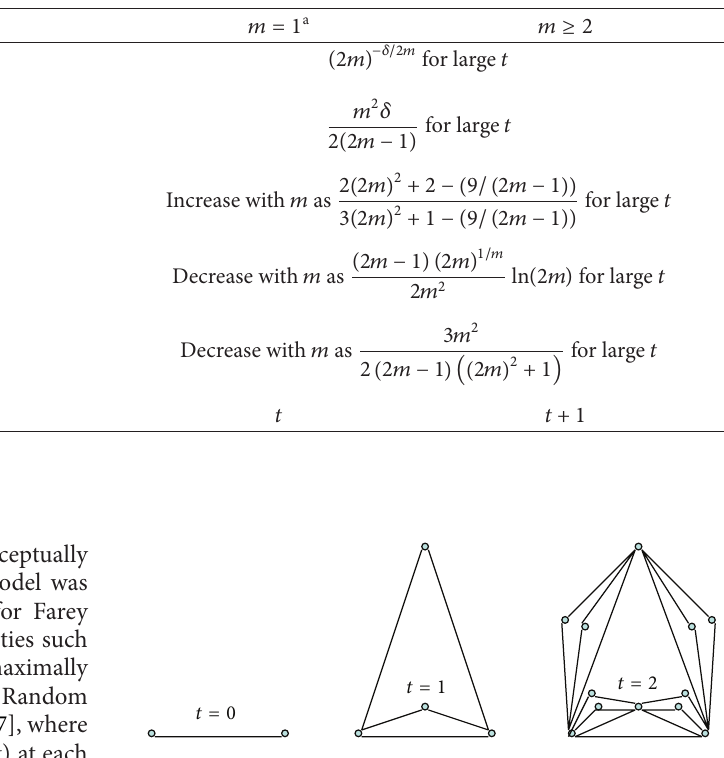
Figure 1: A depiction of graphs 𝐺(𝑚,𝑡) produced at iterations 𝑡 = 0, 1, 2 with 𝑚 = 2 .